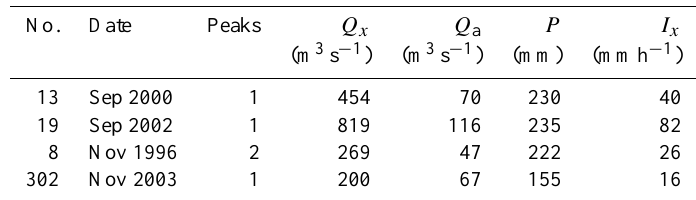
Table 5. Main characteristics of the events selected for the test step ( Q x : peak discharge, Q a : average discharge, P : average rainfall during the event and I x : maximum observed hourly intensity).